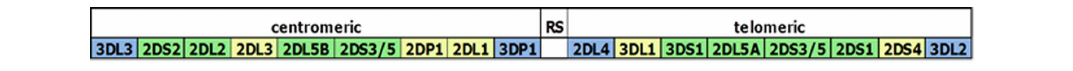
sequence. B-haplotype defining genes are depicted in green color, and A-haplotype defining genes are depicted in yellow color.The framework genes that are present in each haplotype are blue.